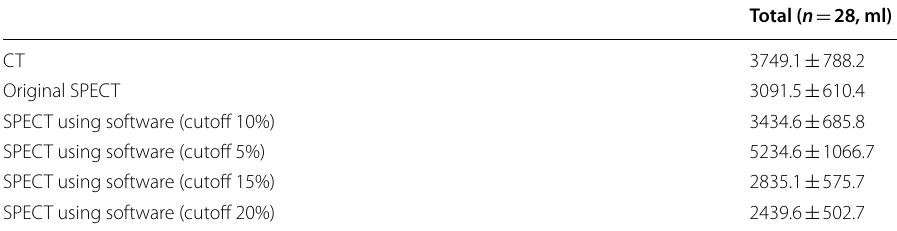
Table 2 The volume of lung calculated using CT and lung perfusion SPECT